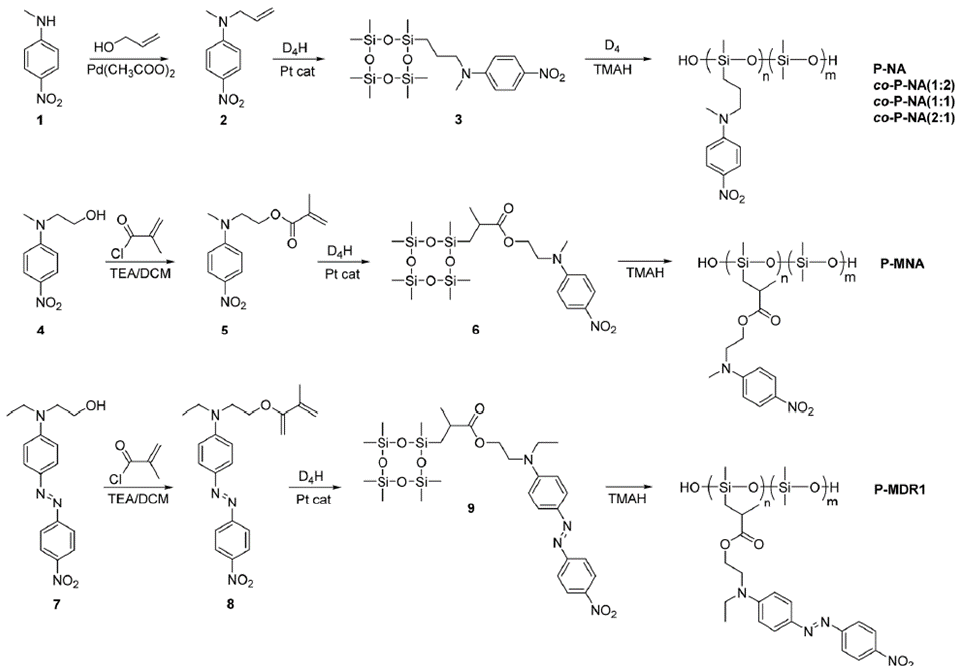
Figure 34. Synthesis of cyclosiloxanes containing nitroaniline and Disperse Red 1 group sand their ring opening polymerization (reprinted with permission from Ref. [152]. 2018, Perju, E).